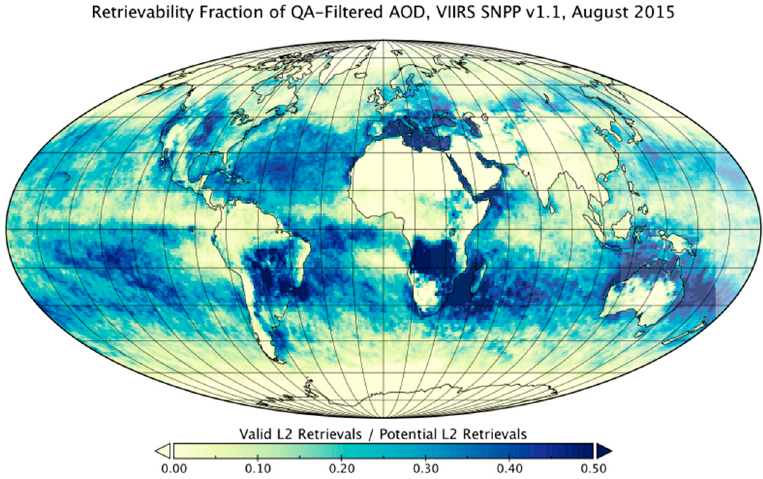
Figure 8. Fraction of retrieval boxes within the VIIRS SNPP level 2 swath where 0.55 µ m AOD could be retrieved in August 2015. The global mean retrievability is 0.18.